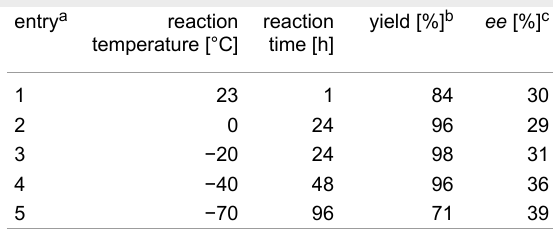
Table 3: Influence of temperature on the Diels-Alder